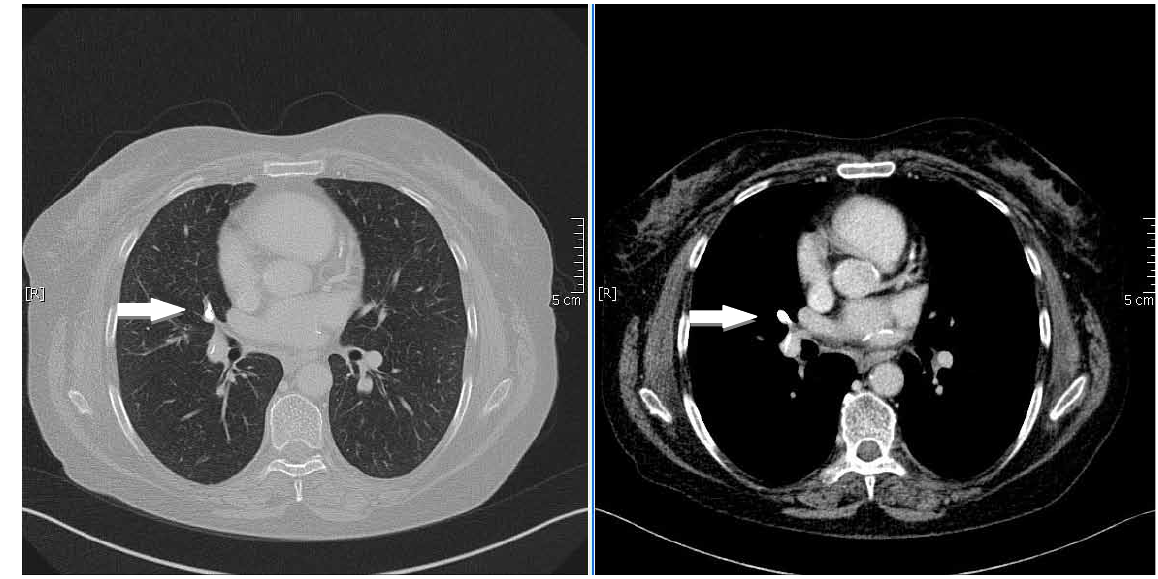
Figure 1. Contrast enhanced CT scan showed cement embolus in a peripheral right middle lobe pulmonary